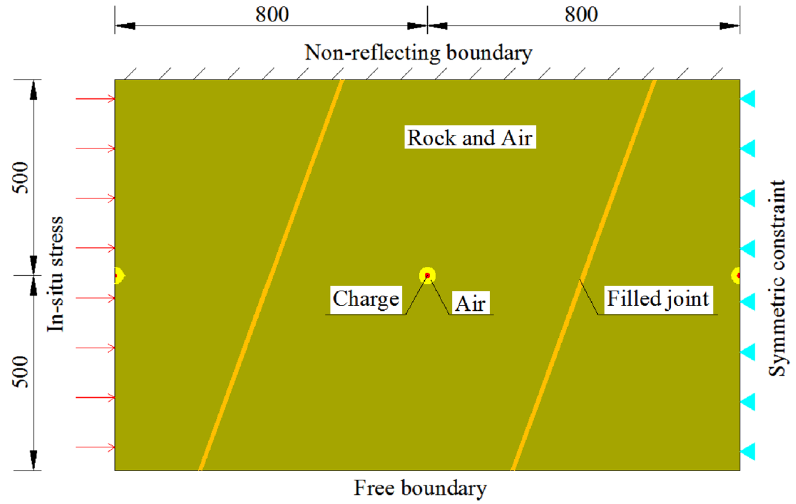
Figure 11. Schematic diagram of TSC fracture blasting numerical model with notched PBH at different joint directions (unit: mm).